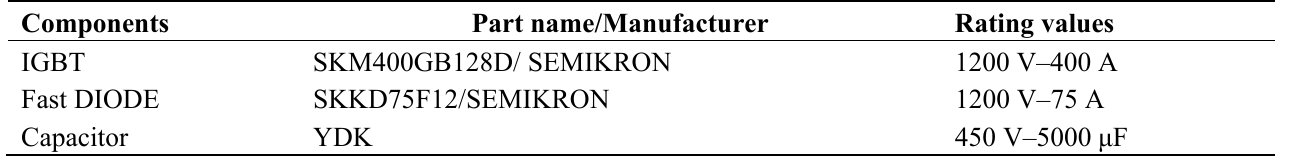
Table A1. Power transistor specifications adopted for the three-phase NPC-VSC inverter. Components